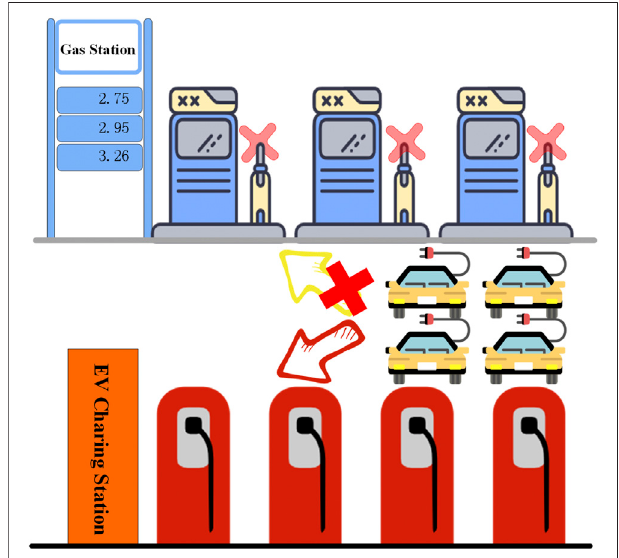
FIGURE 2 | Schematic diagram of PHEV energy acquisition with GSNs being